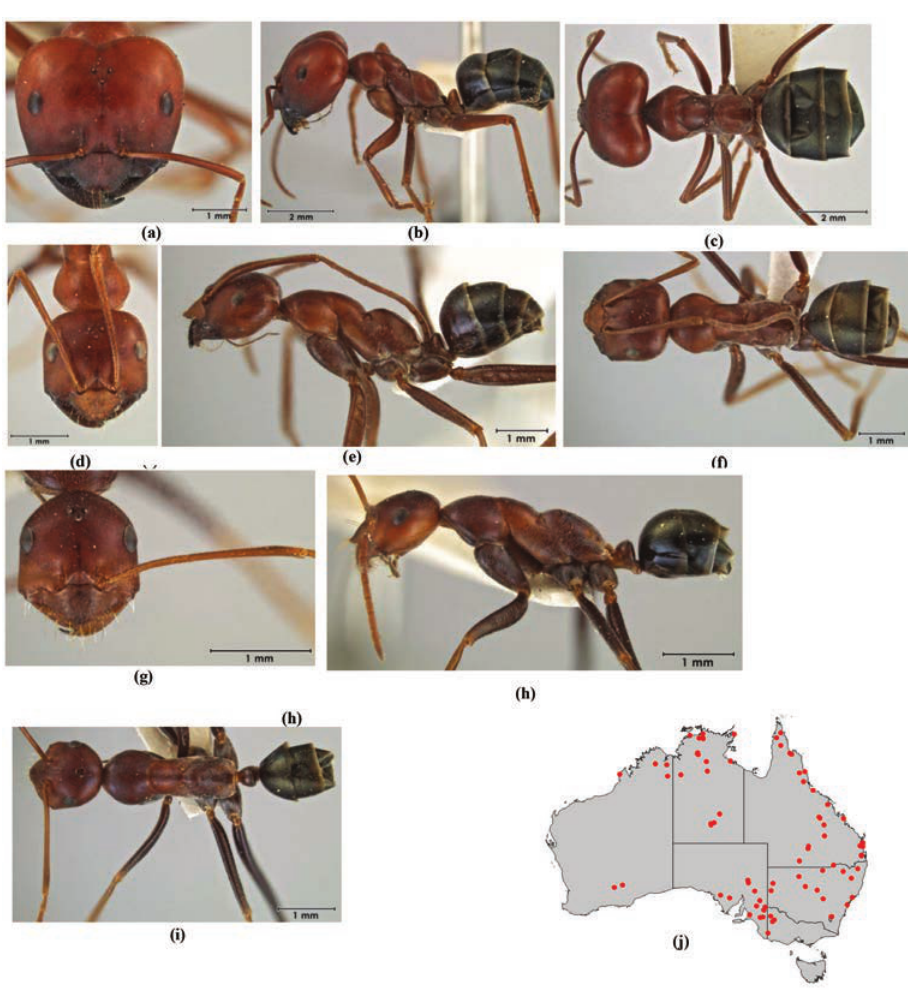
Figure 19. Melophorus rufoniger sp. n.: major worker paratype (ANIC32-066641–top ant) frons ( a ), pro- file ( b ) and dorsum ( c ); paratype media worker (ANIC32-046417) frons ( d ), profile ( e ) and dorsum ( f ); minor worker holotype (ANIC32-066663–bottom ant) frons ( g ), profile ( h ) and dorsum ( i ); distribution map for the species ( j